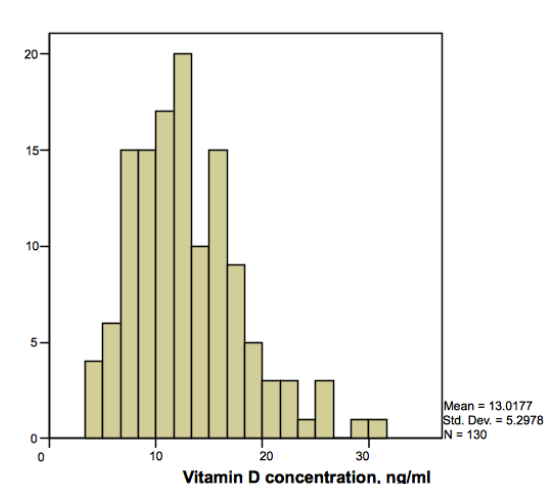
Figure 1 Distribution of vitamin D concentration in all the participants of the